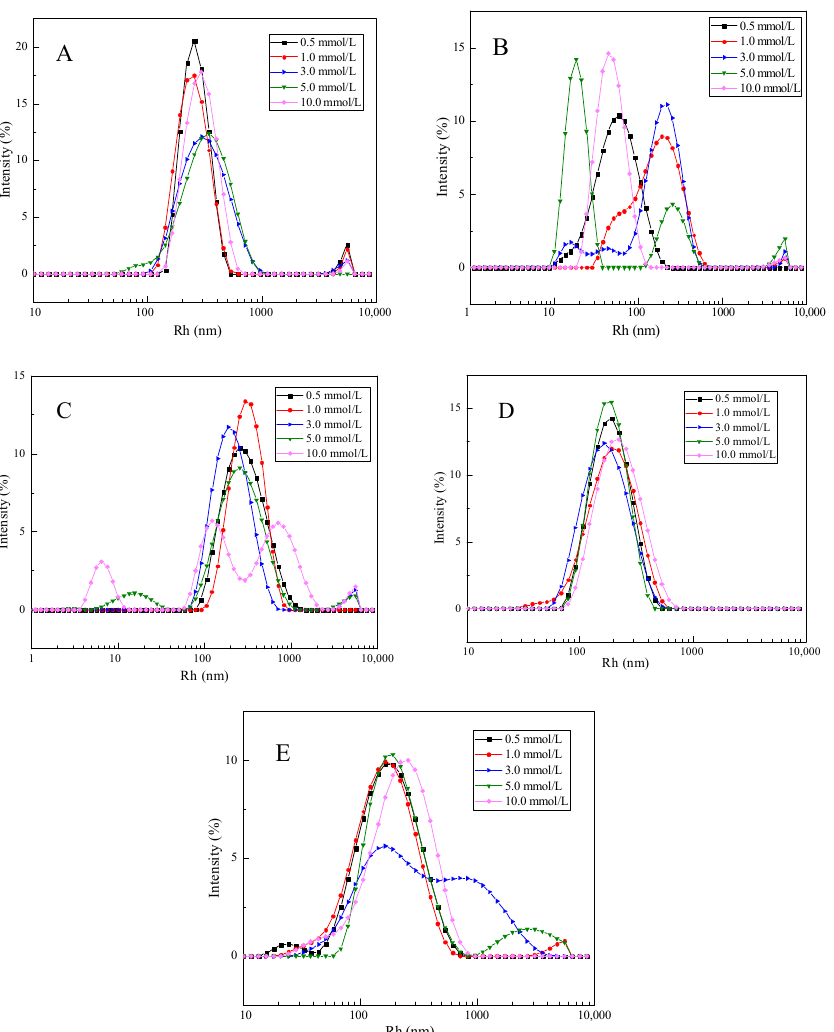
Figure 9. TEM of C n DDGPB at 5.0 mmol/L:( A ) C 8 DDGPB, ( B ) C 10 DDGPB, ( C ) C 12 DDGPB, ( D ) C 14 DDGPB, ( E ) C 16 DDGPB.